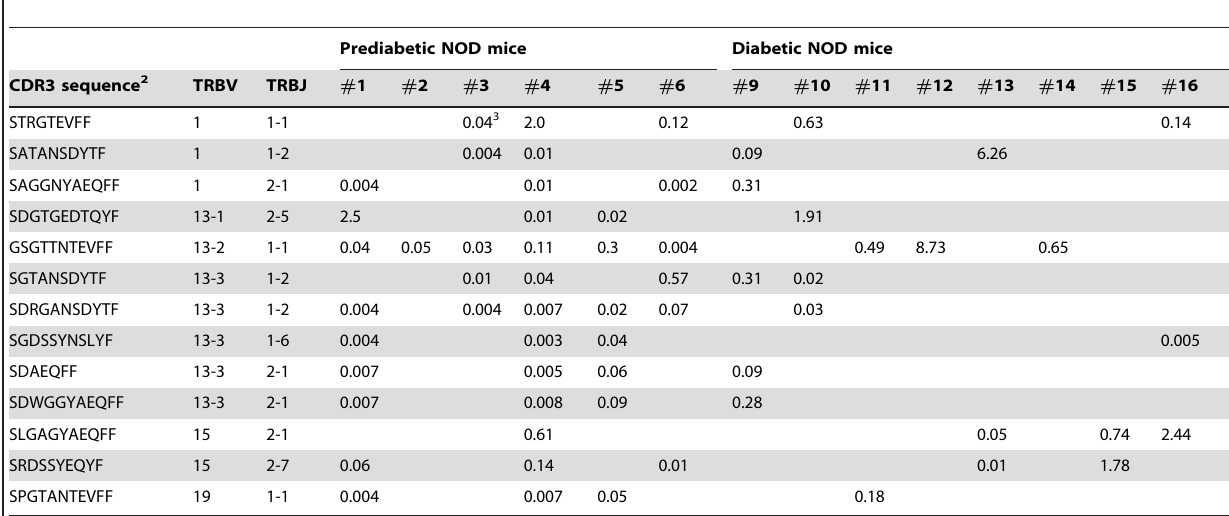
Table 3. Islet-infiltrating CD4 + CD44 high cell clonotypes shared by prediabetic and diabetic NOD mice 1 .